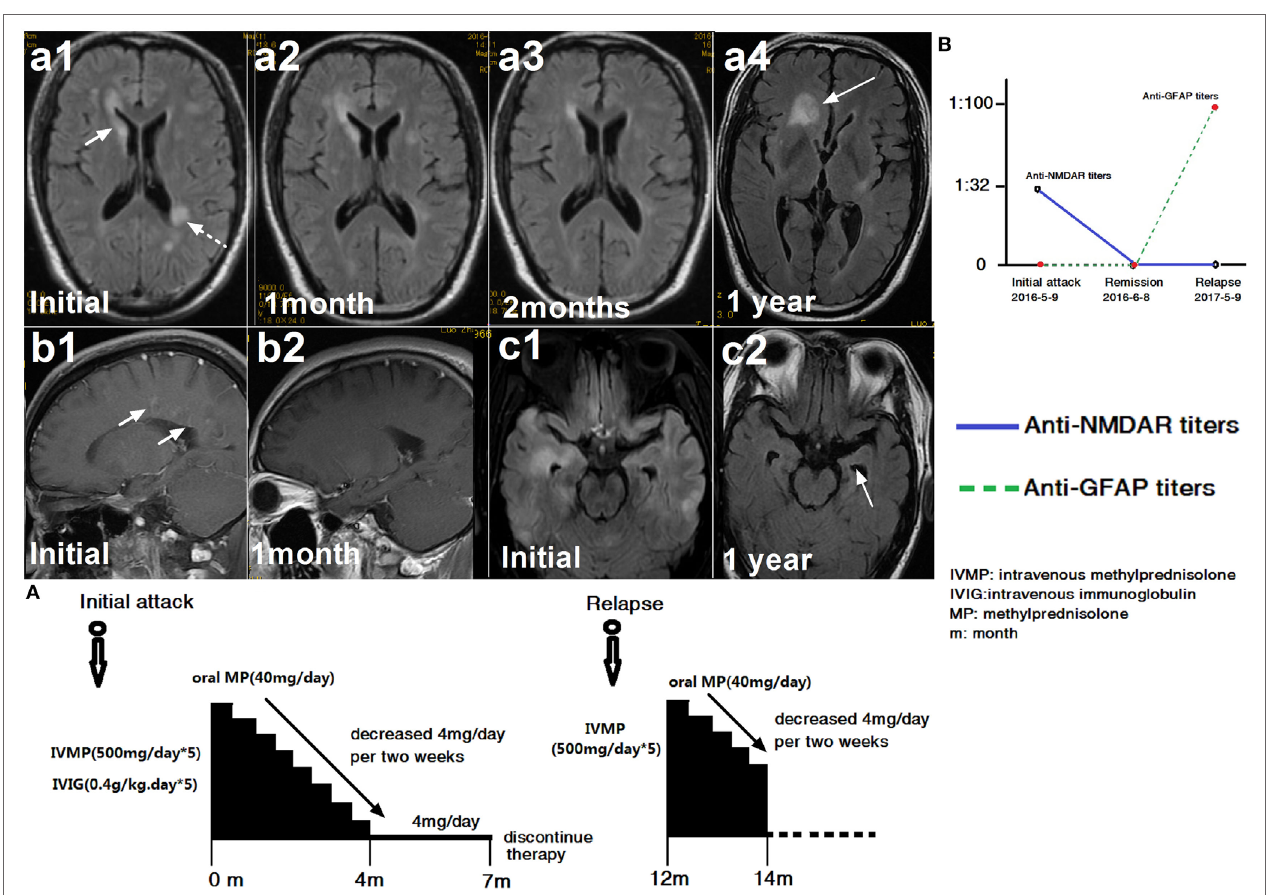
FigUre 2 | A patient with glial fibrillary acidic protein (GFAP) astrocytopathy following anti- N -methyl- d -aspartate receptor (NMDAR) encephalitis. (a1–c2) Brain magnetic resonance imagings (MRIs). (a) Treatment course. (B) NMDAR and GFAP antibody titers. The first brain MRI showed lesions in the right caudate nucleus, white matter along the ventricle (a1) and enhancement around vessels (b1) . At this time, cerebral spinal fluid (CSF) showed positive NMDAR-IgG at 1:32 titer. The patient was treated with intravenous methylprednisolone (500 mg/day for 5 days) and intravenous immunoglobulin (0.4 g/kg for 5 days). At follow-up, an MRI scanning showed improvement in the brain abnormalities (a2, a3) and the disappearance of enhancement (b2) . One month later, NMDAR-IgG and GFAP-IgG were negative. However, the patient relapsed 1 year later due to discontinuation of oral steroid. At this time, the MRI showed a large lesion in the frontal lobe (a4) . Compared with the initial MRI scan, left hippocampal atrophy (c1, c2) was found. At this time, CSF was positive for GFAP antibody but negative for NMDAR antibody (B)